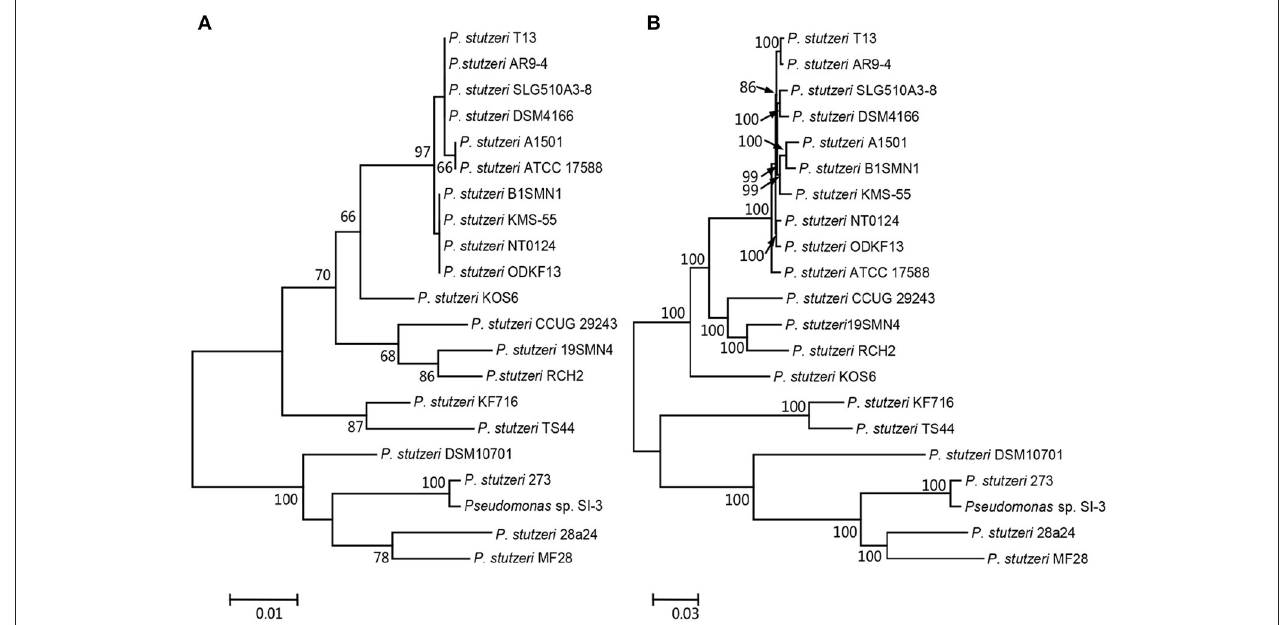
FIGURE 3 | Phylogenetic trees of Pseudomonas sp. strain SI-3 and 20 other P. stutzeri strains. The Maximum Likelihood (ML) phylogeny trees were constructed based on amino acid sequences of housekeeping gene rpoD (A) and concatenated amino acid sequences of single copy orthologous genes (B) . The topology of the tree was tested with 1,000 bootstrap replications and bootstrap values were shown near the horizontal branches of the